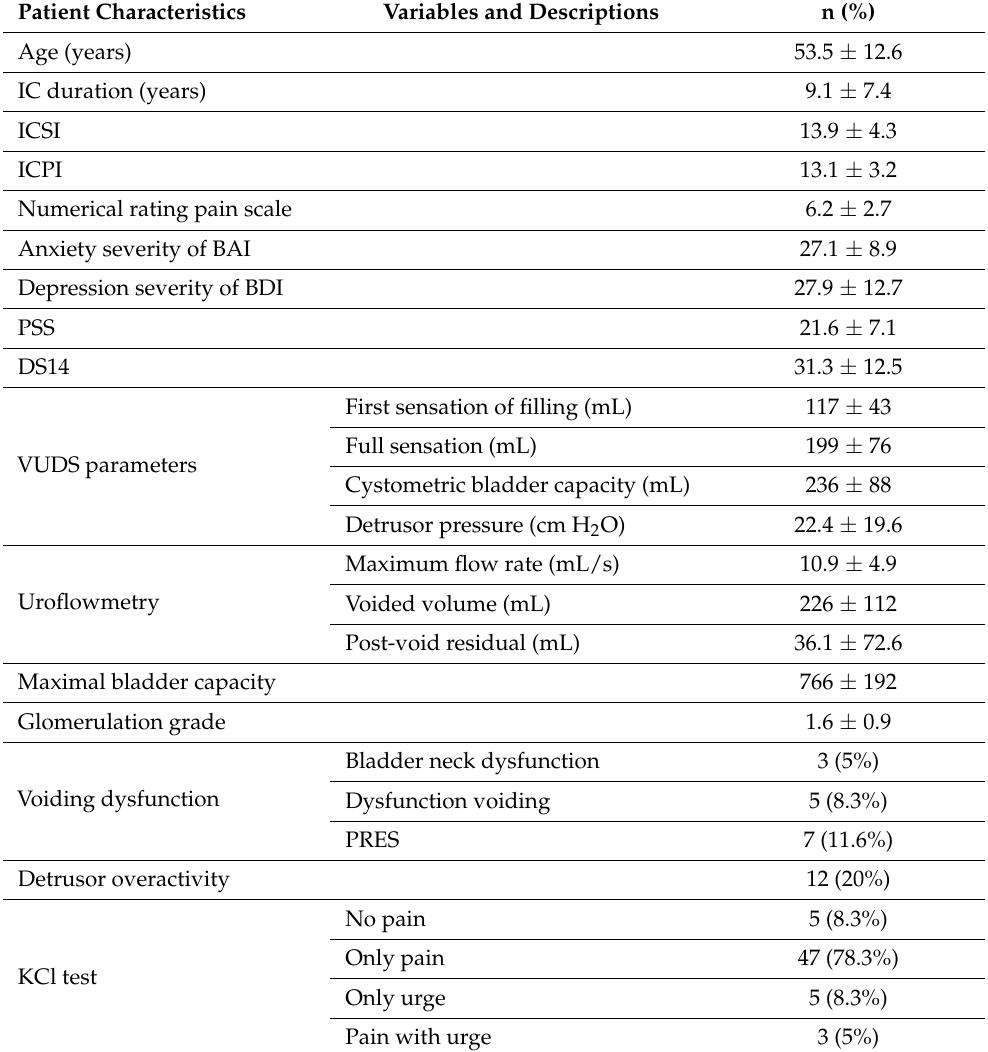
Table 1. Baseline demographic data of patients with interstitial cystitis/bladder pain syndrome ( n =